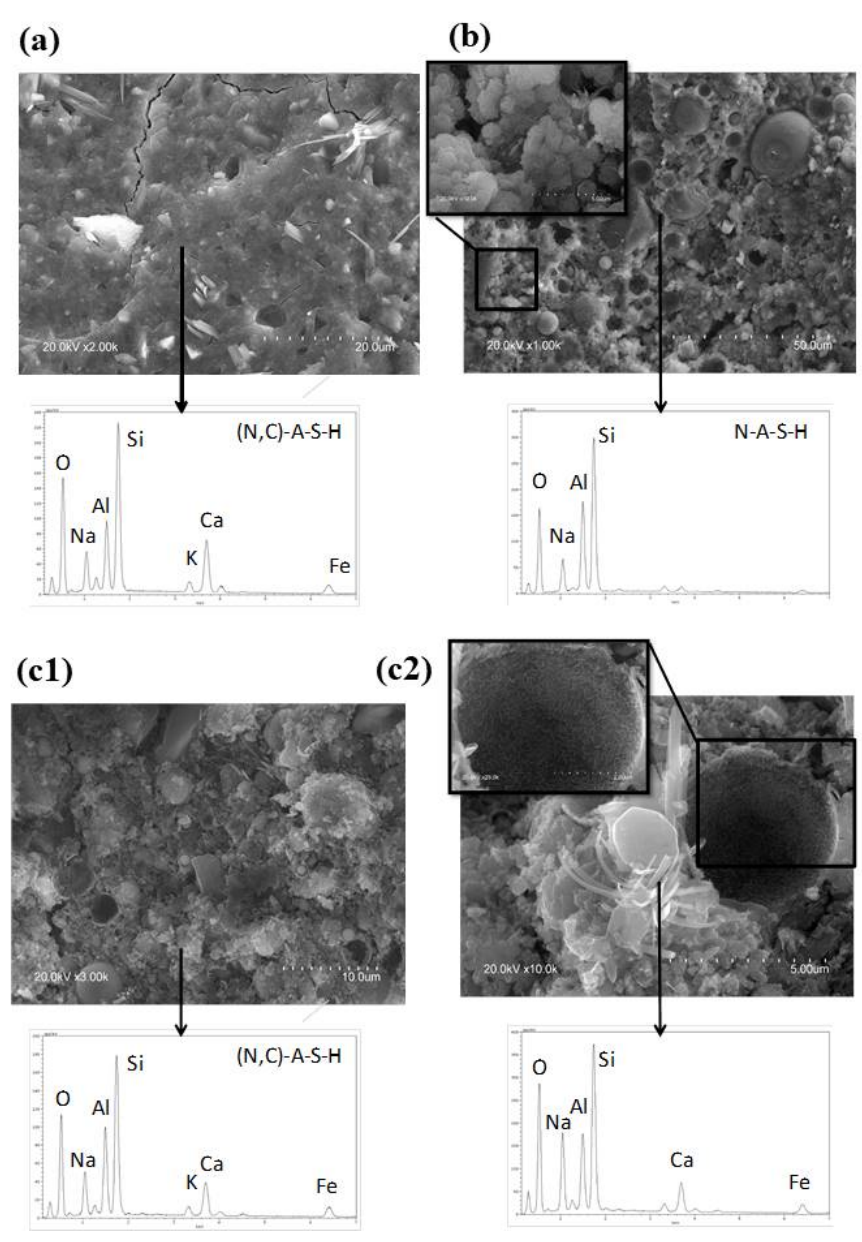
Figure 7. SEM micrographs and EDS spectra of ( a ) MA57_8M, ( b ) FAB_8M, and ( c1 ) MA57F_8M after 28 days and ( c2 ) high magnification image of c1. Scale bar and magnification are shown in the image.